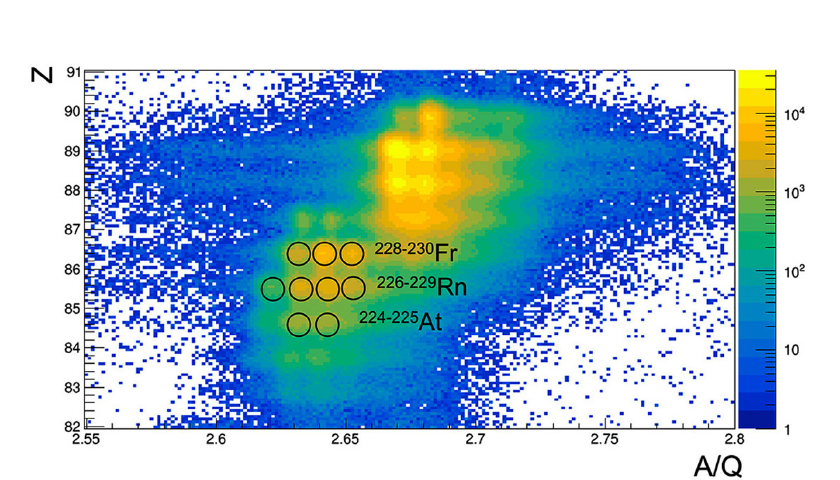
Fig. 4. – Particle identification plot obtained for our experimental